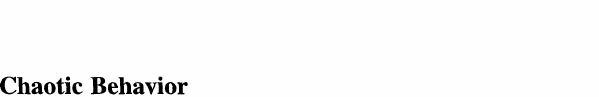
FIGURE 7 Oscillations of X in the interval: T [60, 100].